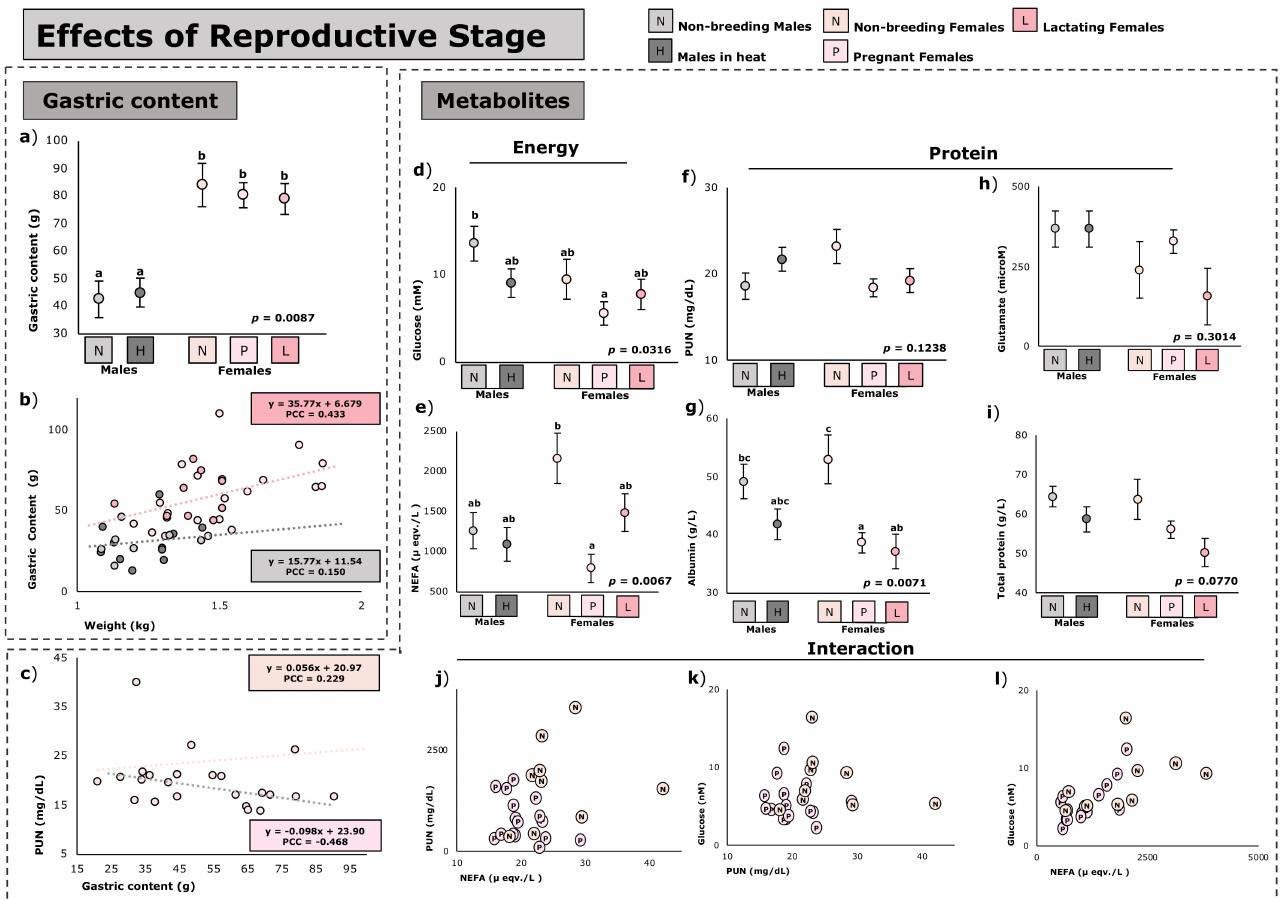
Figure 2. Effect of reproductive stage on the full stomach contents and metabolism of Oryctolagus cuniculus ( n = 62). Least square means ± standard errors, ( a – c ); least square means in the same graph with no common superscripts differ significantly at p < 0.05 ( a , d – i ). Relationship between digestive contents with weight and the tendency of males and females ( b ). Relationship between plasmatic urea nitrogen (PUN) with digestive contents, and the tendency of non-breeding females and pregnant females (Figure 2c). Here, PCC is Pearson correlation coefficient. The relationship between animal’s PUN and non-esterified fatty acids (NEFA) ( j ) or with glucose ( k ), and the relationship between glucose and NEFA ( l ) in non-breeding females and pregnant